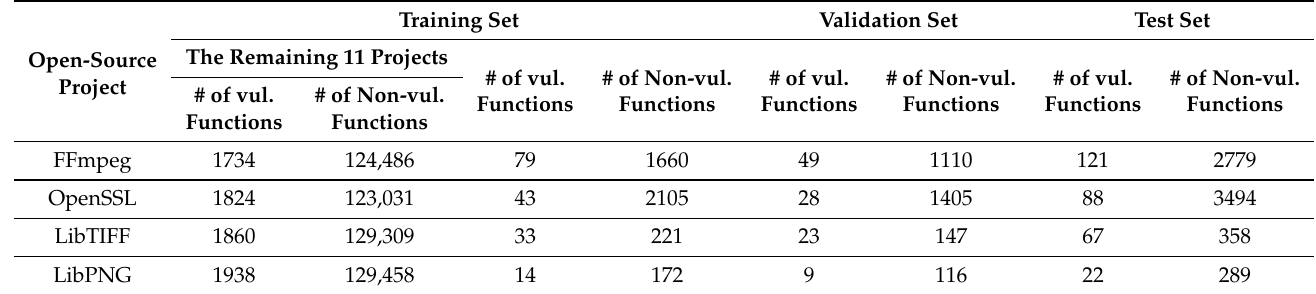
Table 5. The experiment setting for answering RQ4, listing the partitioned data set of individual software projects for evaluation, including FFmpeg, OpenSSL, LibTIFF, and LibPNG. When one project is used for evaluation, the remaining 11 projects are used for